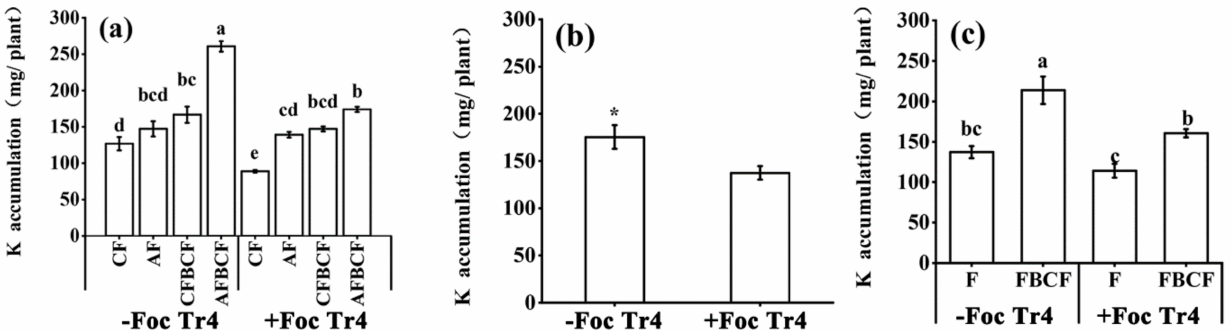
Figure 7. Effects of alkaline fertilizer and biocontrol fungi on K accumulation in banana 60 days after Foc Tr4 inoculation. ( a ) Effect of each treatment on K accumulation. ( b ) Effect of inoculation of pathogen (main plot) on K accumulation. ( c ) Effect of biocontrol fungi (sub-plots) on K accumulation. Different letters on top of the bars indicated significant difference ( p < 0.05) among the treatments. * indicated that there was significant difference between − Foc Tr4 and +Foc Tr4 (0.01< p ≤ 0.05). CF stands for conventional fertilizer. AF stands for alkaline fertilizer. CFBCF stands for conventional fertilizer and biocontrol fungi. AFBCF stands for alkaline fertilizer and biocontrol